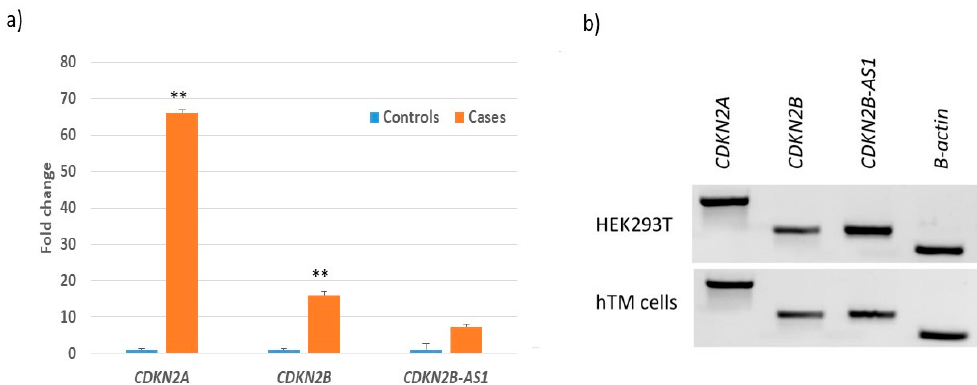
Figure 2. Expression of CDKN2A , CDKN2B and CDKN2B-AS1 transcripts in ocular tissue and cells in ( a ) expression in POAG ( n = 3) and control retina ( n = 3) and ( b ) human trabecular meshwork (hTM) and Human embryonic kidney 293T (HEK293T) cell lines. ‘**’ signifies p < 0.005. 3.4. CDKN2B-AS1 Regulates the Expression of CDKN2B and CDKN2A Transcripts